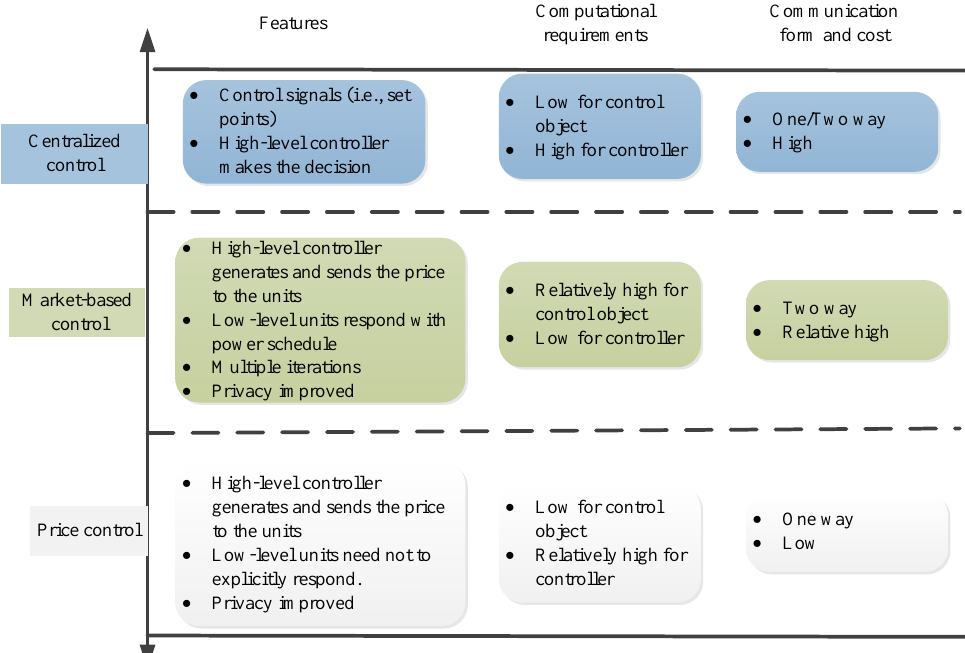
Figure 7. Overview of charging management strategies (adapted from [72]).